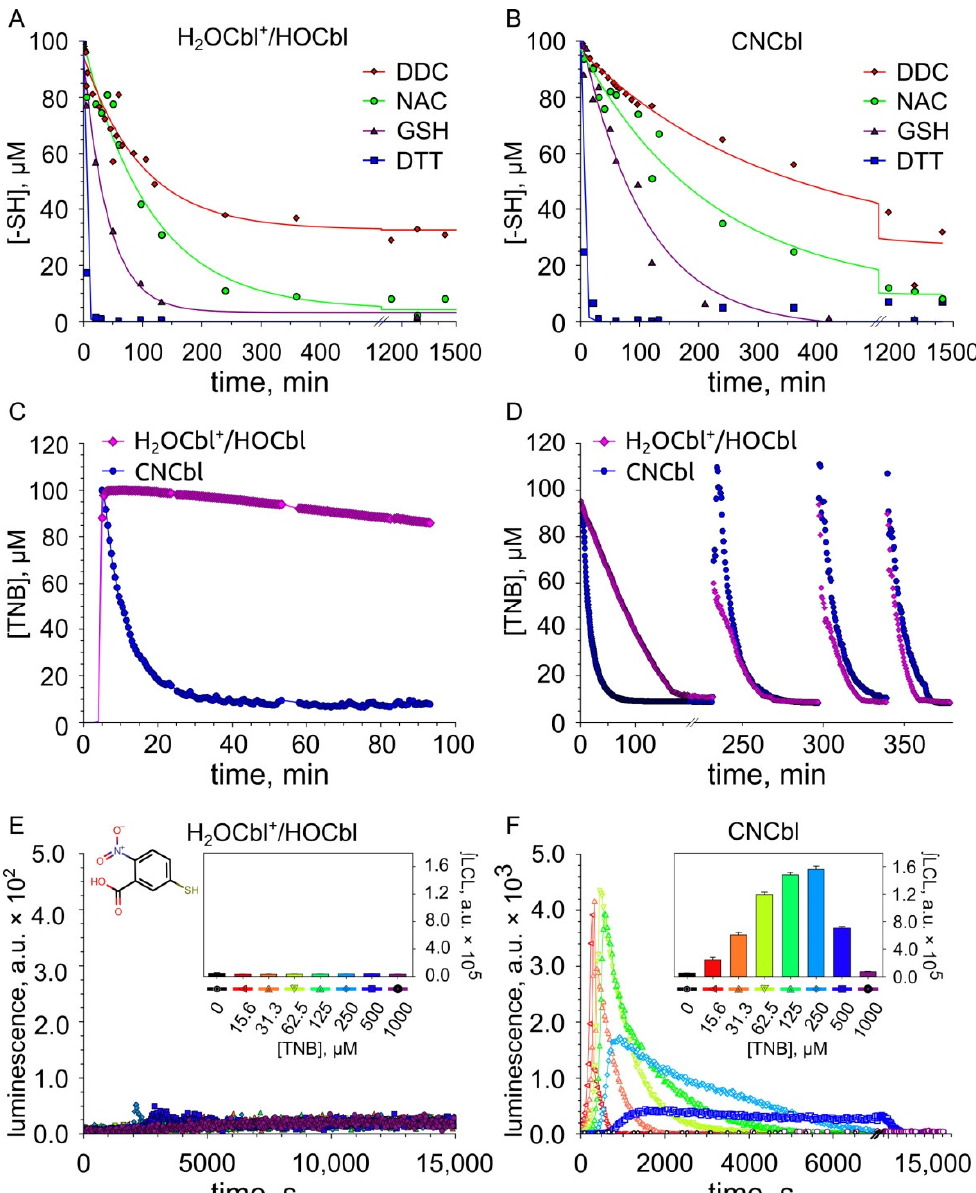
Figure 3. The oxidation of thiols in the presence of cobalamins. ( A , B ) Changes in the concentrations of thiol-containing compounds in the presence of cobalamins. ( C ) Changes in the concentration of TNB formed in the reaction of DTNB with NAC in the presence of cobalamins. ( D ) Changes in the concentration of TNB preliminarily formed in the reaction of DTNB with DTT in the presence of cobalamins during four catalytic cycles. ( E , F ) Chemiluminescence recorded during the oxidation of TNB in the presence of cobalamins. Inserts: Dependence of integral chemiluminescence response (∫LCL) on the concentration of TNB.